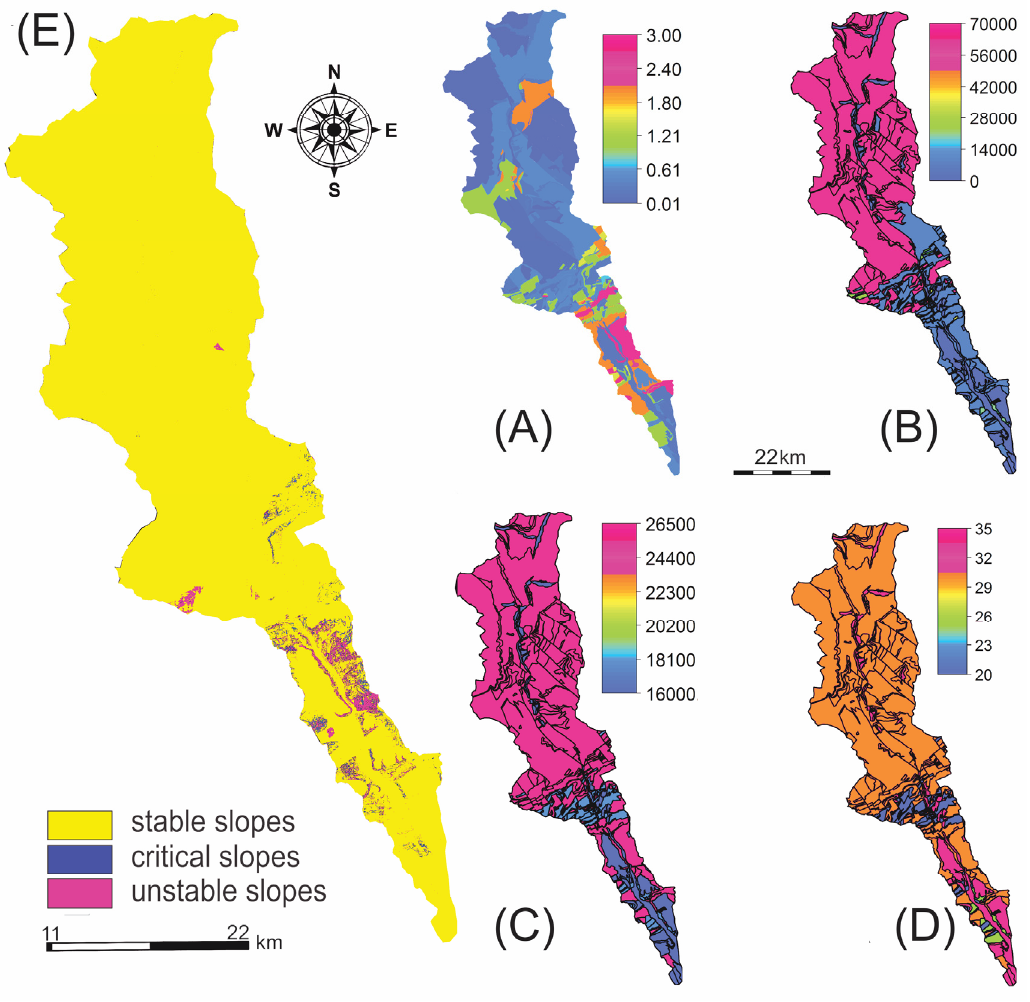
Figure 5. The distributions of ( A ) soil thickness, m; ( B ) cohesion, N/m 2 ; ( C ) unit weight, N/m 3 ; ( D ) friction angle ( ˚ ). ( E ) Slope failure susceptibility map using the deterministic approach under completely saturated conditions.